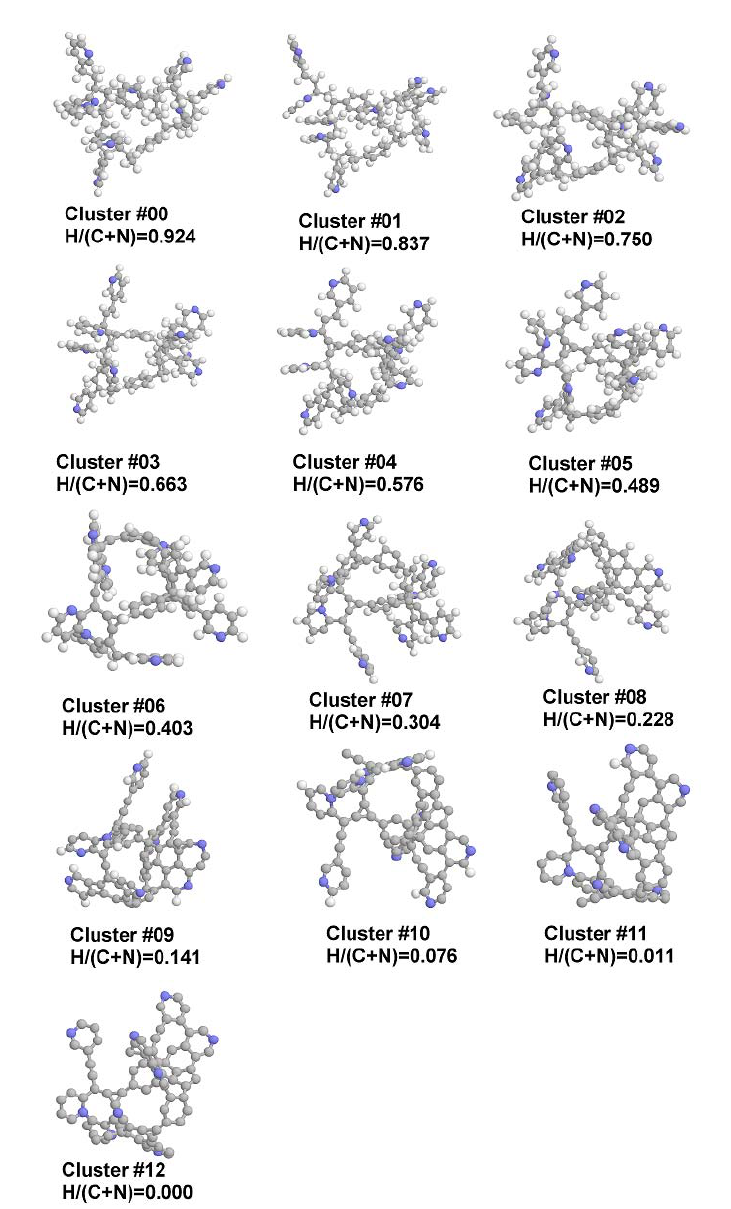
Figure 1. Structures of studied clusters (point number) and H/(C + N)